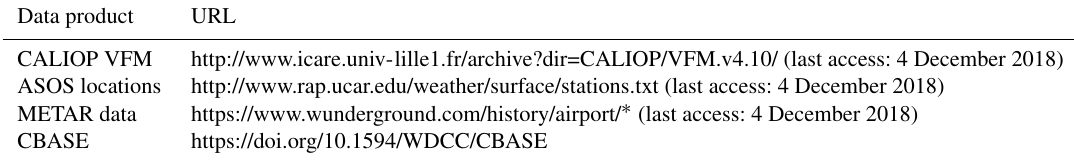
Table 1. Data sources used in this analysis.